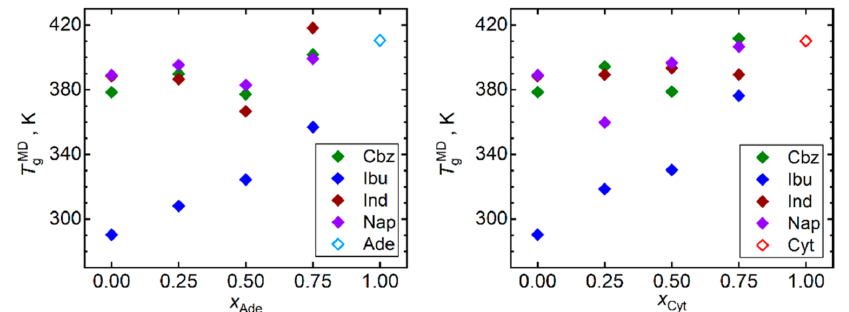
Figure 2. Glass transition temperatures T g obtained by the trend shift method from MD simulations of densities and diffusivities (results averaged) of mixtures of nucleobases (adenine, Ade—left; and cytosine, Cyt—right) with API (carbamazepine, Cbz; RS-Ibuprofen, Ibu; Indomethacin, Ind; and naproxene, Nap).